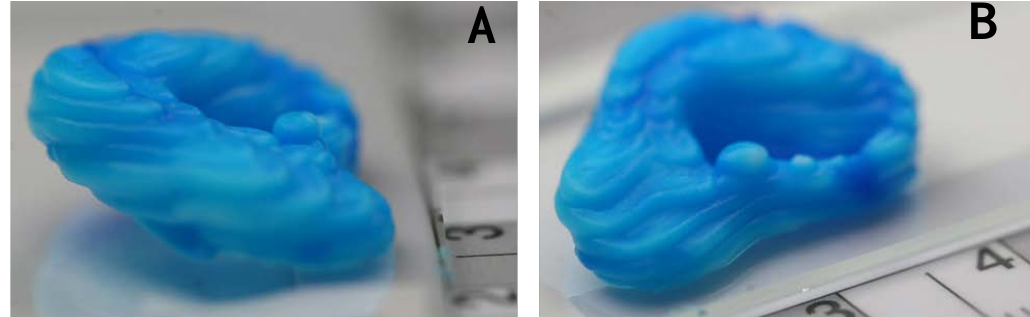
Figure 7. Test prints of a model of a human ear using optimal settings for extrusion pressure and print speed derived from the Taguchi analysis of the print parameters. ( A ) End view of test print; ( B ) Side view of test print.